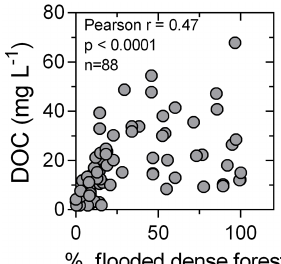
Figure 4. Relationships between DOC concentrations in tributaries and the extent of flooded dense forest.